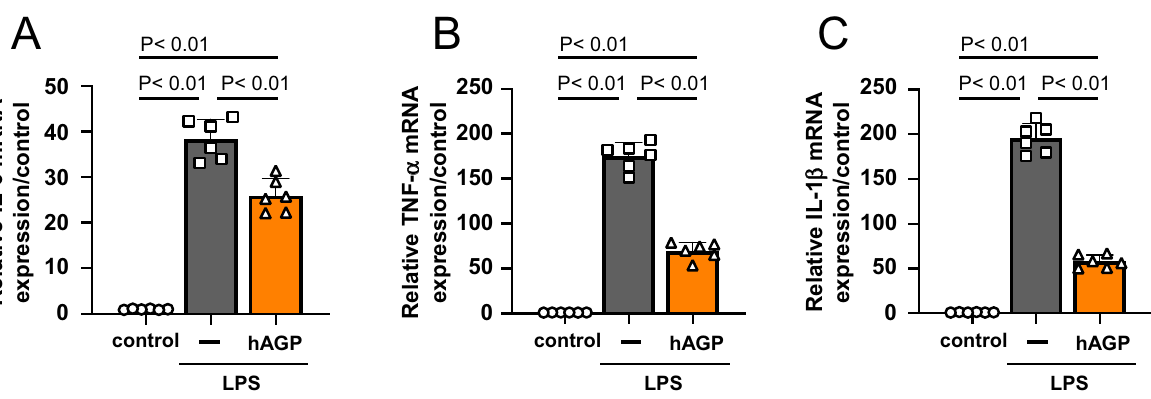
Figure 6. hAGP ameliorates lipopolysaccharide-induced macrophage inflammatory response. RAW 264.7 were exposed to 1.0 mg/mL D-PBS or hAGP for 48 h, and then exposed to 100 ng/mL LPS in the absence of hAGP for 3 h. mRNA expression of ( A ) IL-6, ( B ) TNF-α and ( C ) IL-1β in RAW 264.7 were determined by real-time PCR. Data are expressed as the mean ± SE (n =